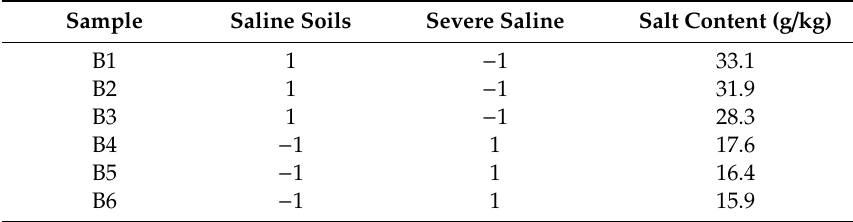
Table 4. Comparison of extension classification correlation value and salt content in Area B’s calibration